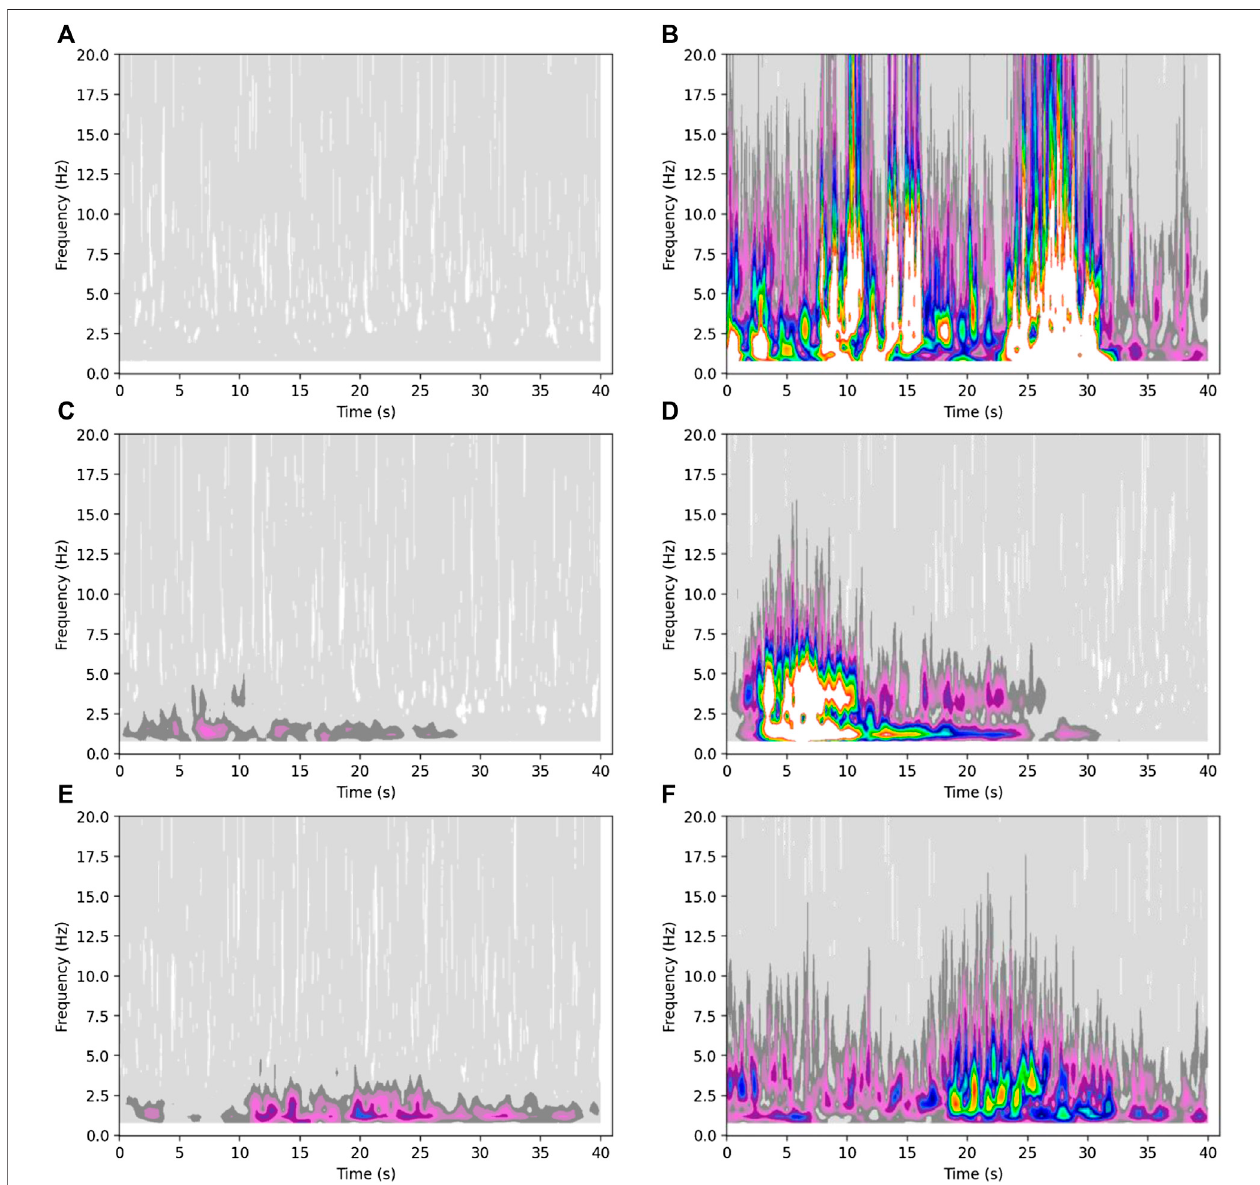
FIGURE 4 | Time – frequency domain characteristics of vibrations: (A – B) normal vibrations with low amplitude and high amplitude, (C – D) simulated structural seismic responses with low amplitude and high amplitude, and (E – F) real monitored structural seismic responses with low amplitude and high amplitude.